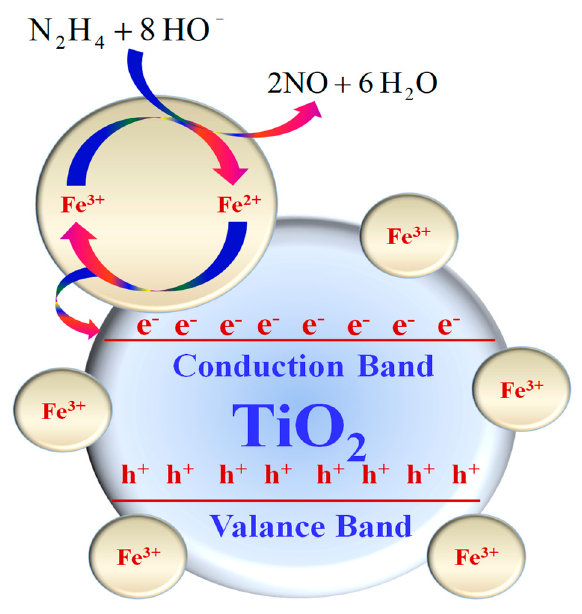
Figure 6. Proposed mechanism for the hydrazine sensing by Fe-doped TiO 2 nanoparticles.